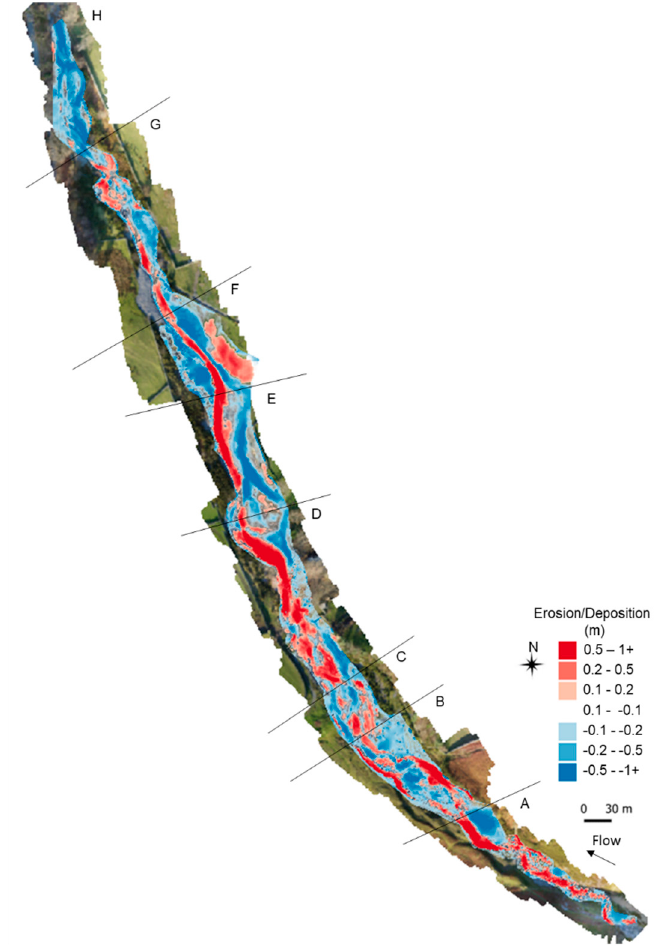
Figure 5. Erosion and deposition pattern recorded along Liza Beck between 2009 and 2017 most strongly reflecting the December 2015 extreme rainfall event in the catchment.